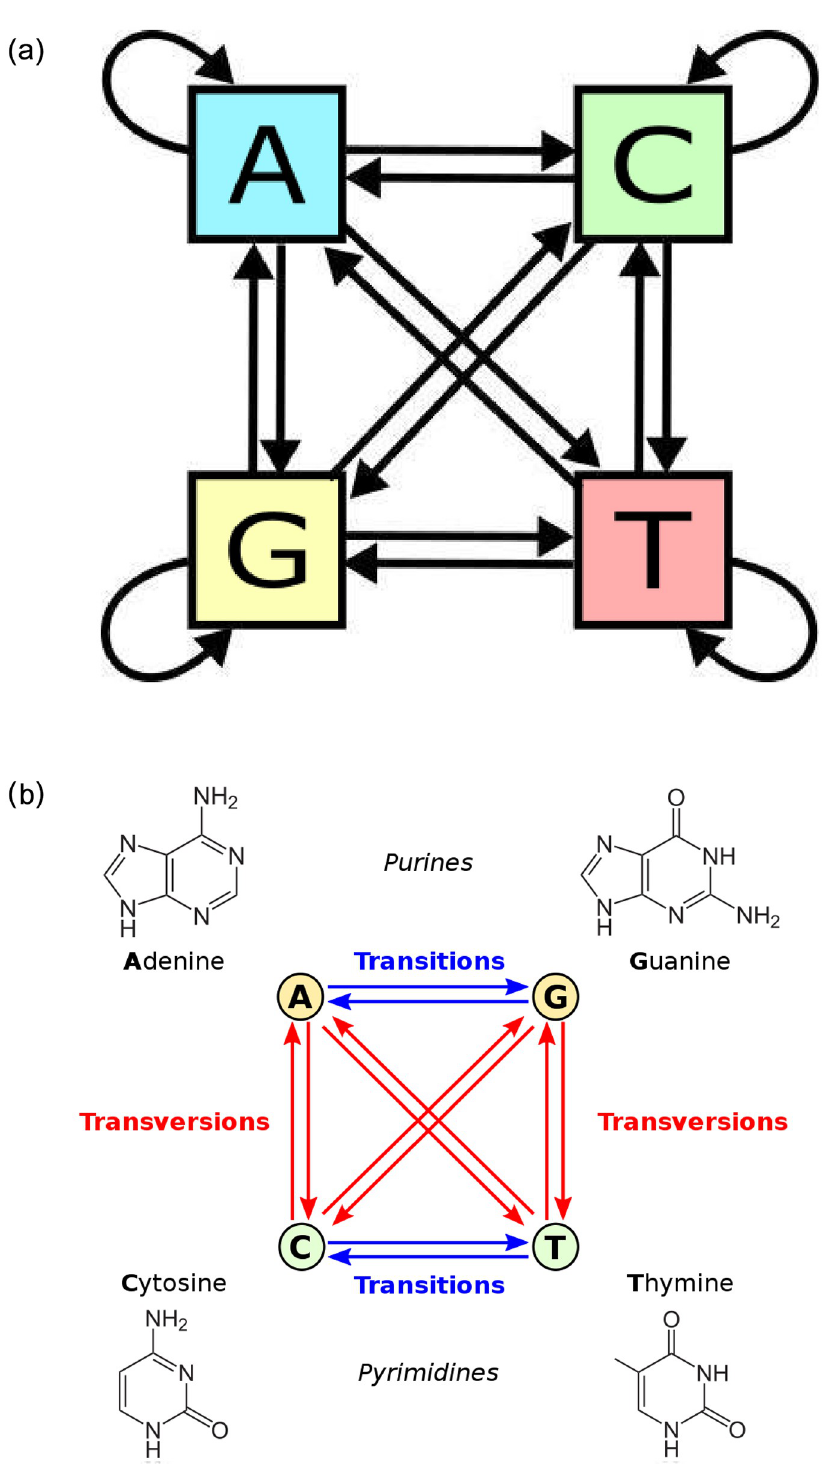
Fig 3. State transition diagrams. (a) Markov state transitions, (b) Corresponding nucleotide transversions and transitions.